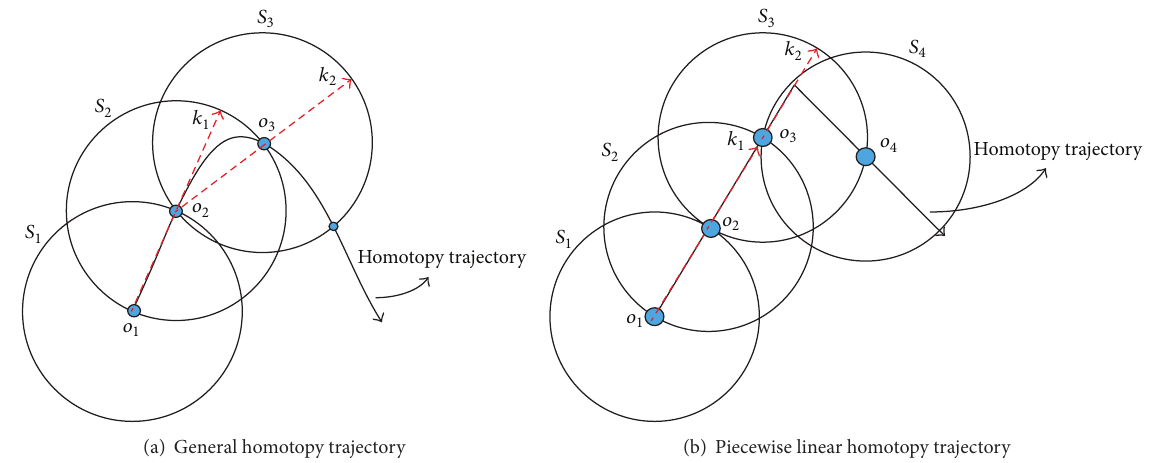
Figure 2: Spheres algorithm [37].